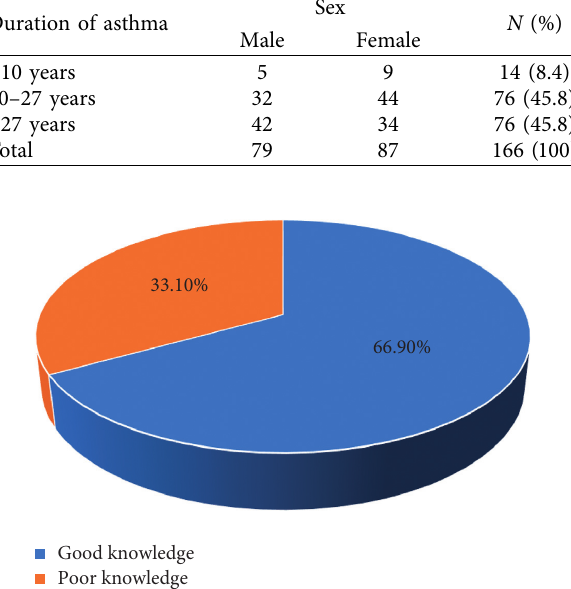
Figure 1: Knowledge regarding the disease and metered-dose inhaler, DMCSH,